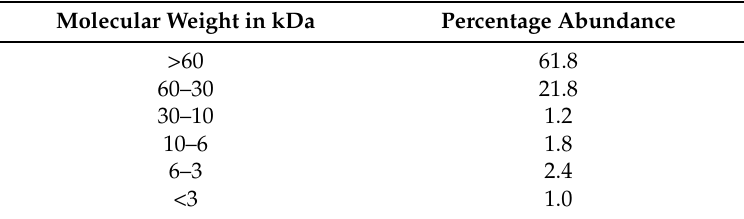
Table 4. Molecular weight distribution of lignin in black liquor